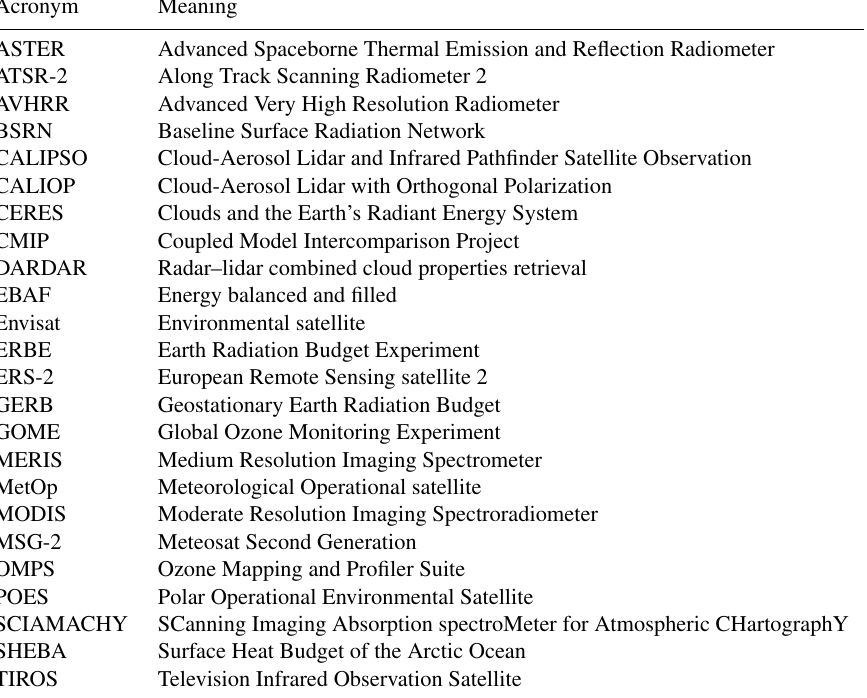
Table A1. List of abbreviations used in the